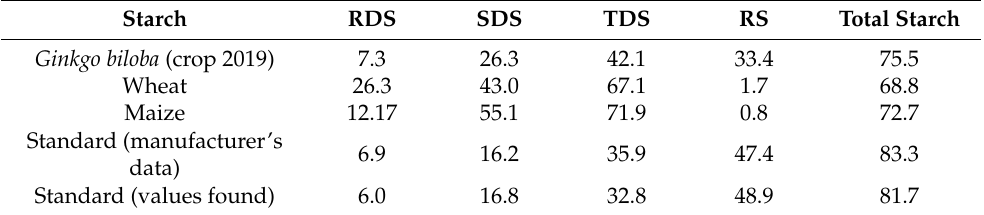
Table 3. Rate of in vitro enzymatic hydrolysis of four types of starch. RDS—rapid digestible